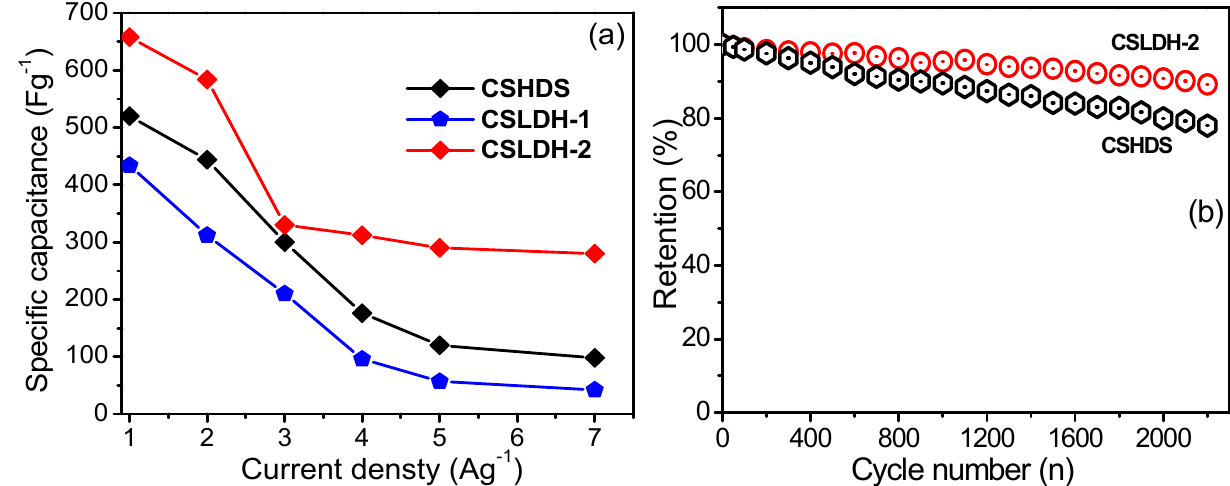
Figure 13. ( a ) Calculated specific capacitance CSHDS, CSLDH-1 and CSLDH-2 at different current densities in 2M KOH aqueous electrolyte and ( b ) Cyclic stability of CSHDS and CSLDH-2 at 4 Ag − 1 over 2200 cycles.